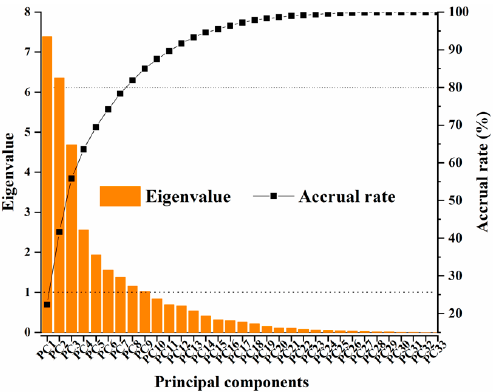
Figure 6. Eigenvalues and cumulative contribution rates for principal component analy- sis.